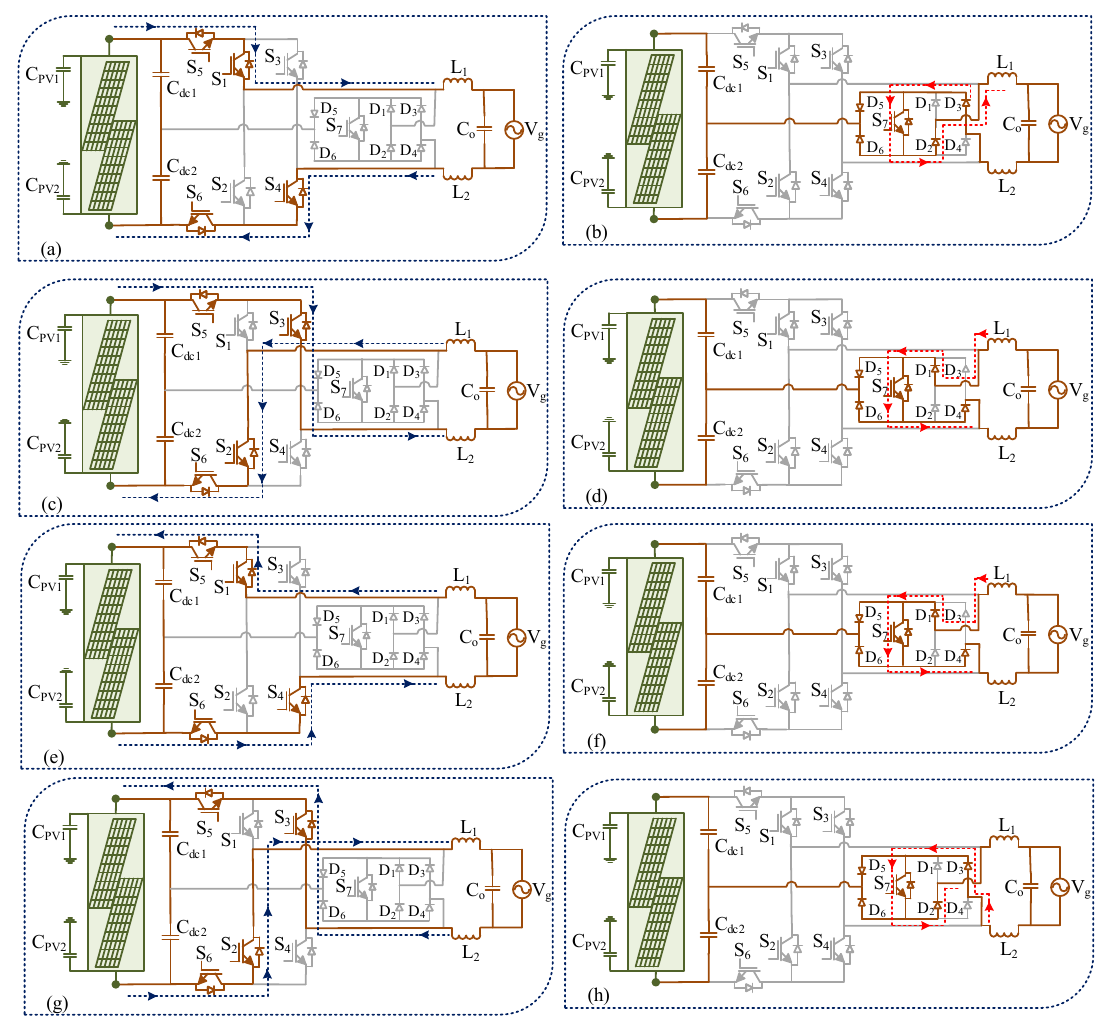
Figure 9. Conduction modes under non-unity power factor: ( a ) mode 1 ( V A B = + V DC ), ( b ) mode 2 ( V AB = 0), ( c ) mode 3 ( V AB = − V DC ), ( d ) mode 4 ( V A B = 0), ( e ) mode 5 ( V AB = + V DC ), ( f ) mode 6 ( V AB = 0), ( g ) mode 7( V AB = − V DC ), ( h ) mode 8 ( V AB = 0). Negative power region: This period also contains four conduction modes, as depicted in Figure 9e–h. In negative power region 1, modes 5 and 6 simultaneously generate + V DC and 0. Likewise, in negative power region 2, modes 7 and 8 simultaneously generate − V DC and zero again. In the negative power region, power flows from the grid to PV Table 1. Simulation parameters.